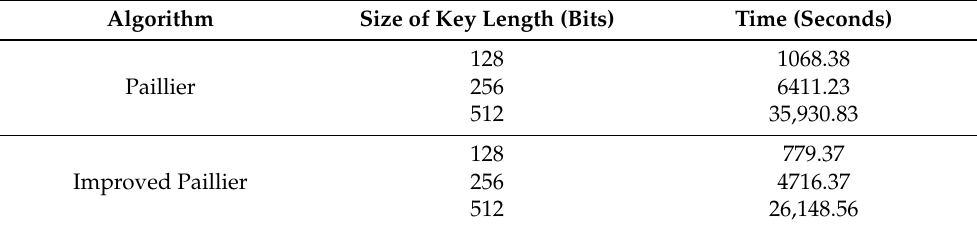
Table 6. The impact of different key lengths on the iteration time of each round.